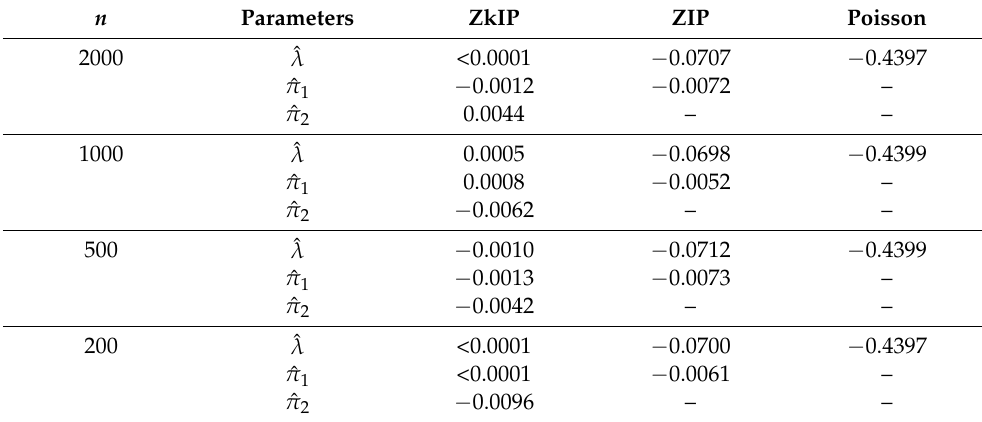
Table 7. Comparison of standardized bias (SBias) of the simulated data. True values λ = 5, π 1 = 0.4, π 2 = 0.1, and k = 3.